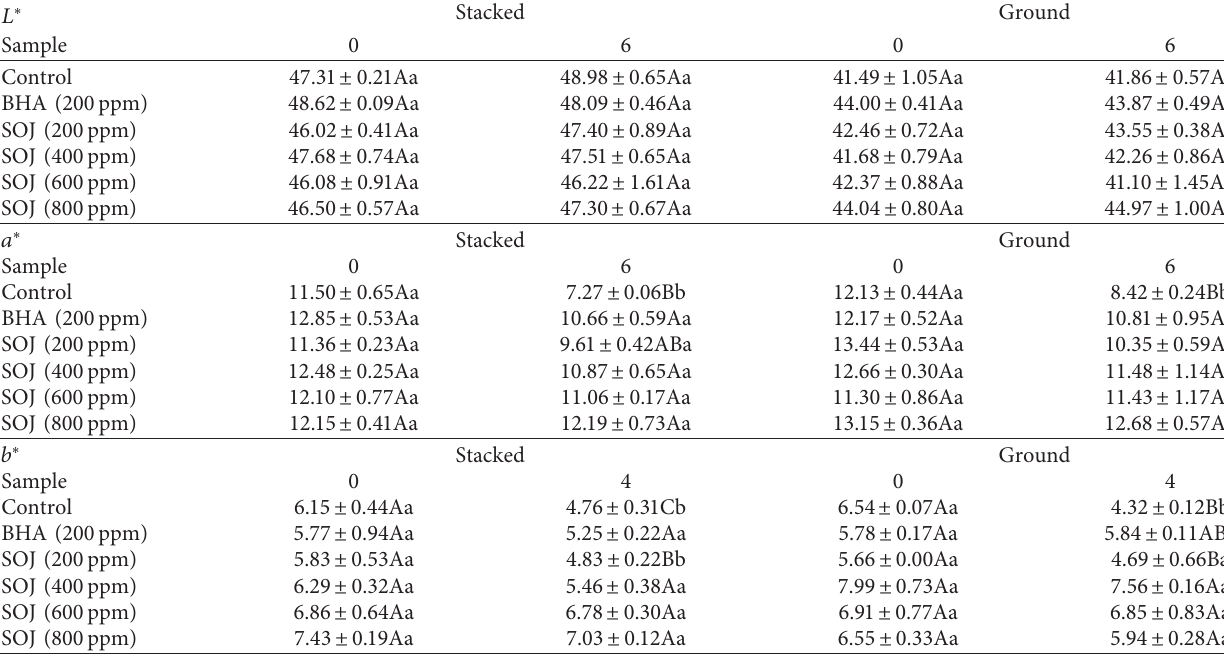
Table 7: Color properties of stacked and ground meat samples incorporated with Shahpouri Orange Juice (SOJ) and BHA during storage at 4 ° C for 6 days.